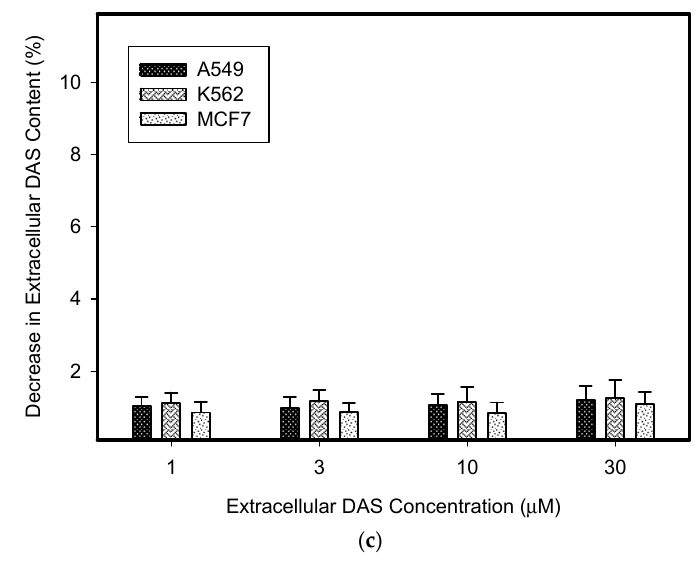
Figure 3. Lysosomal sequestration of TKIs and extracellular drug concentration. ( a ) The effect of lysosomal sequestration of IM on its extracellular concentration. ( b ) The effect of lysosomal sequestration of NIL on its extracellular concentration. ND—not determined (due to limited NIL solubility). ( c ) The effect of lysosomal sequestration of DAS on its extracellular concentration. Columns represent the means and standard deviations of four independent experiments. * denotes a significant change in the decrease in extracellular IM content ( p < 0.05) between the indicated cell lines. ## denotes a very significant change in the decrease in extracellular IM content ( p < 0.01) between the indicated groups.